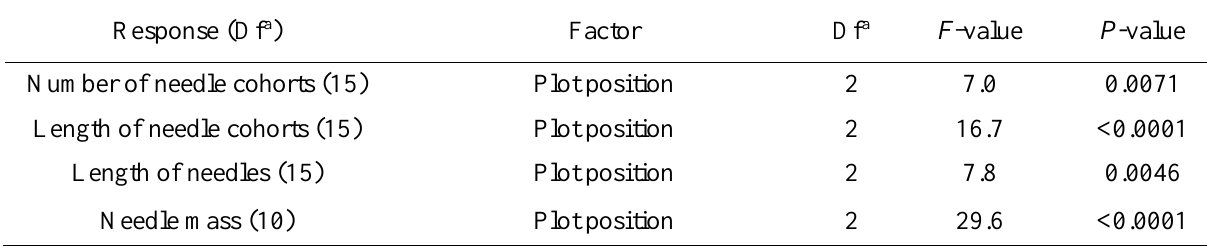
Table 2. Summary of ANOVA-results for linear models to test the effect of plot position on morphological traits of bog pine and Norway spruce. Df = degrees of